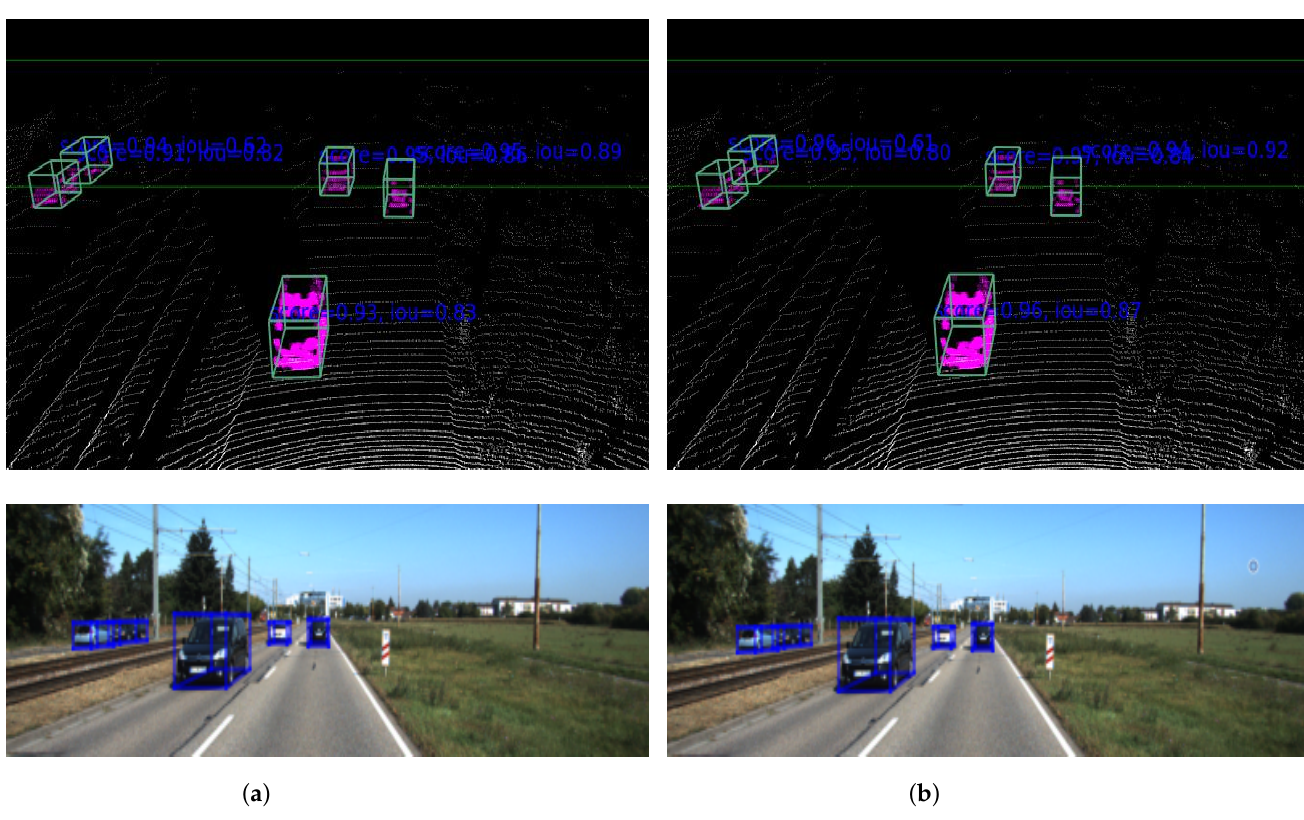
Figure 4. Sample qualitative car class output comparison of the ( a ) PointPillars [9] network and ( b ) our proposed network (zoomed view). For better visualization, we used the bird’s eye view ( top ) and image perspective ( bottom ). The output shows a class score for each image with the corresponding IOU value. The higher the IOU value, the more confident the